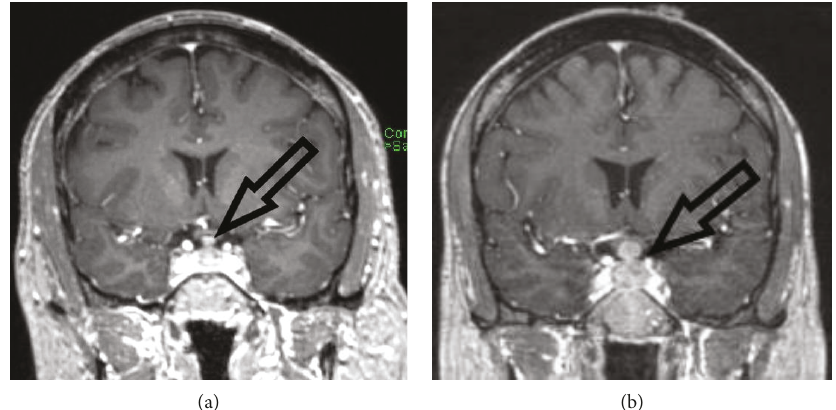
Figure 1: Brain magnetic resonance imaging demonstrating enlarging pituitary mass. (a) T1-weighted MRI demonstrating enlarged pituitary gland containing a hypovascular 10.5 × 7.5mm mass lesion with thickening of the pituitary infundibulum without intracranial hemorrhage or extra-axial fl uid collection. (b) Imaging one month later with T1-weighted MRI demonstrating a 22.0 × 12.0mm bilobed mass with 8mm suprasellar extension exerting mass e ff ect on overlying optic